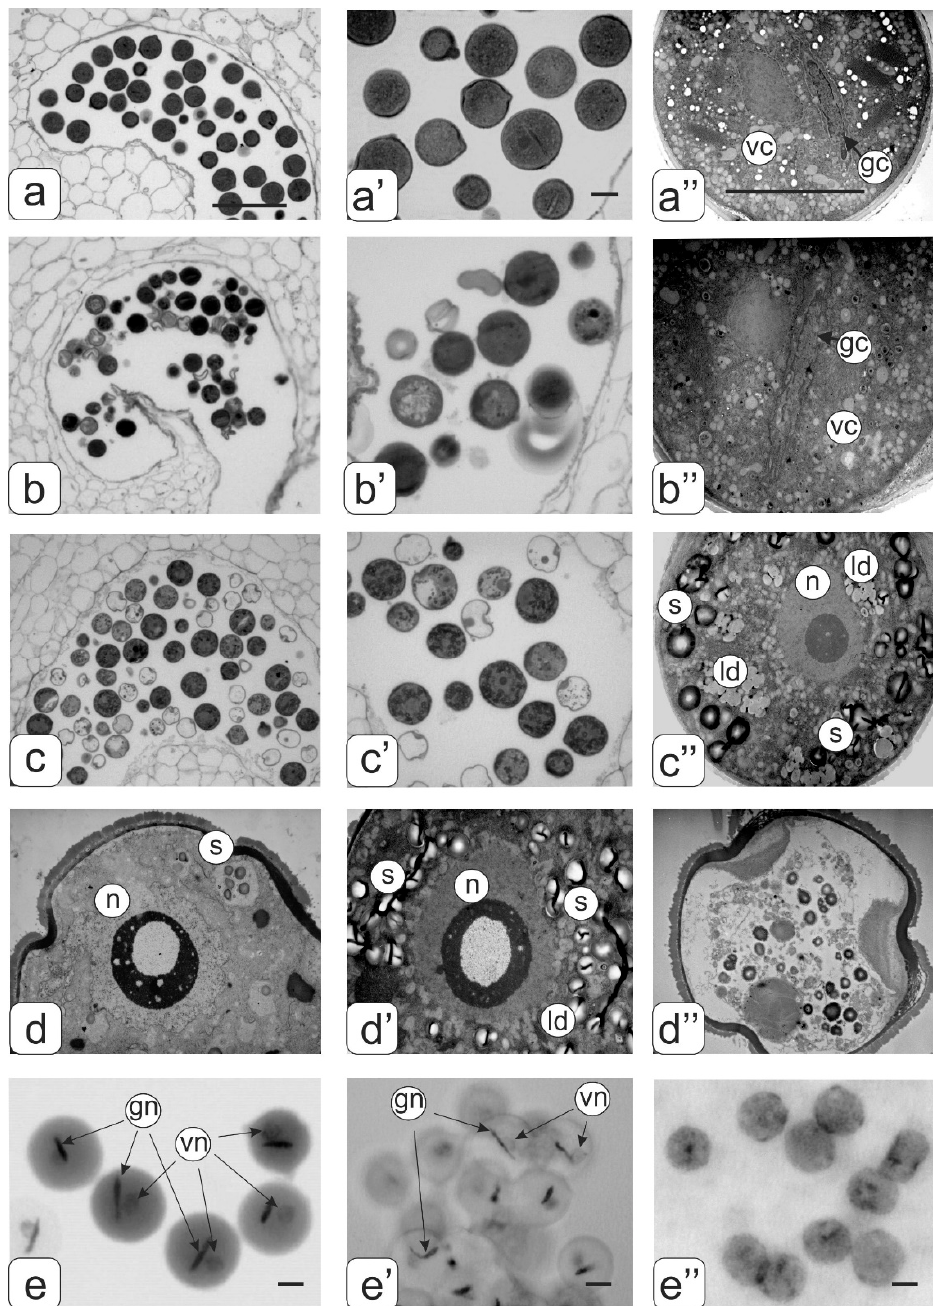
Figure 9. Cross-sections of mature anthers and ultrastructure of pollen in tomato flowers. Pollen sacs ( а ) and pollen grain ( a’ , a” ) from control tomato plants; pollen sacs ( b ) and pollen grain ( b’ , b” ) from transgenic tomato line with normal phenotype; pollen sacs ( c ) and hypertrophic microspore ( c’ , c” ) from transgenic tomato line with abnormalities. Ultrastructure of different abnormal microspores in transgenic tomato plants ( d , d’ , d” ). Pollen grains of control ( e ) as well as transgenic tomato plants with normal ( e’ ) abnormal phenotypes ( e’’ ) stained by the Feulgen. Symbols: g с —generative cell; vc—cell; n—nucleus; gn–generative nucleus; vn—vegetative nucleus; ld—lipid drops, s—starch. Bar: a, b, c—25 μ m; other—4 μ m.